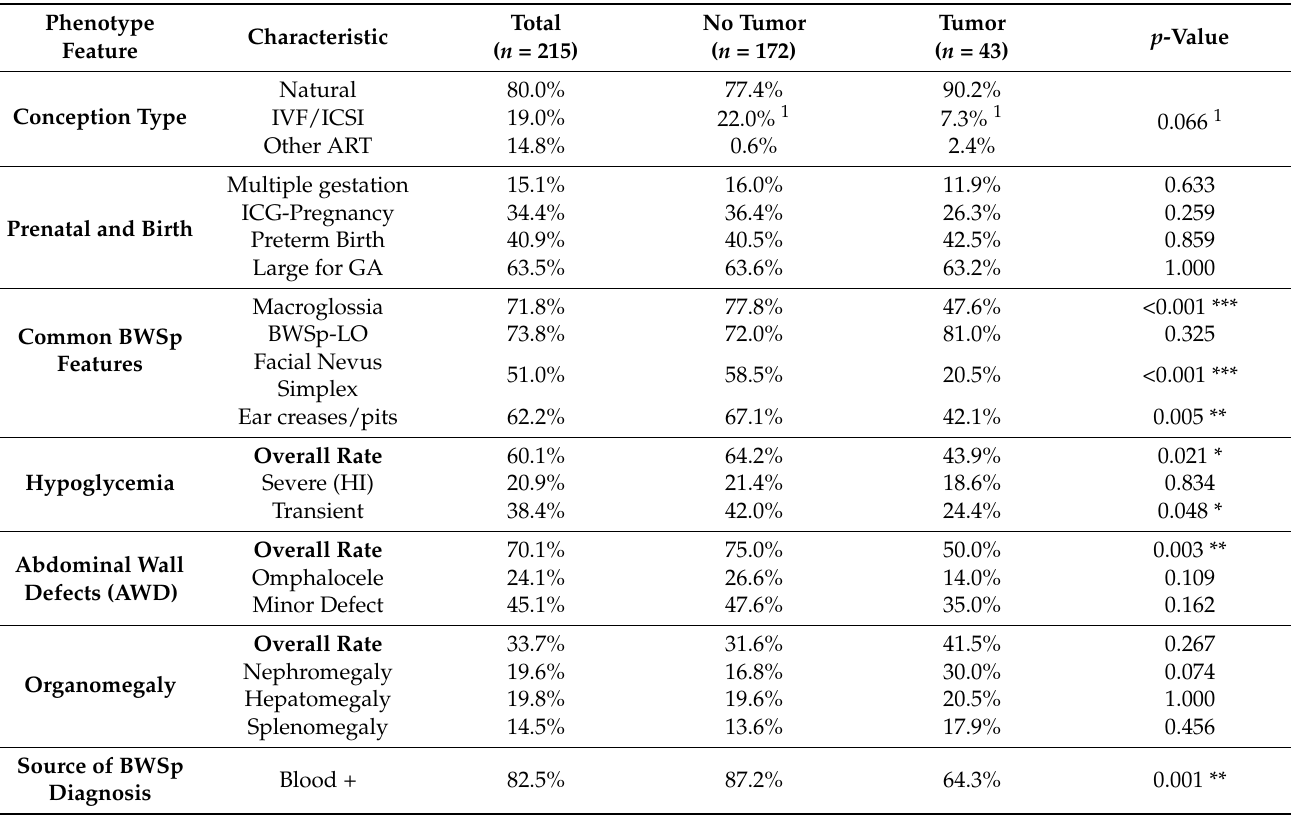
Table 4. Summary of phenotypes associated with cancer history in BWSp study